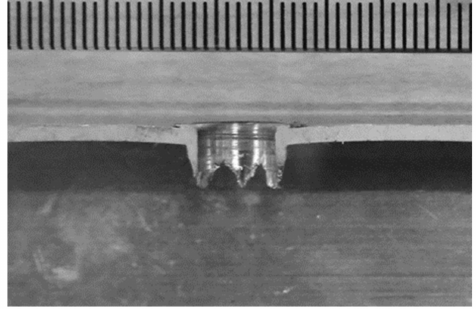
Figure 1. Section-view of the hole created by friction